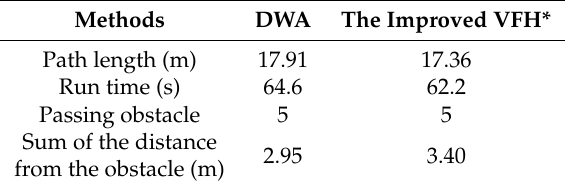
Table 1. Experimental results of parameters in the path planning without virtual